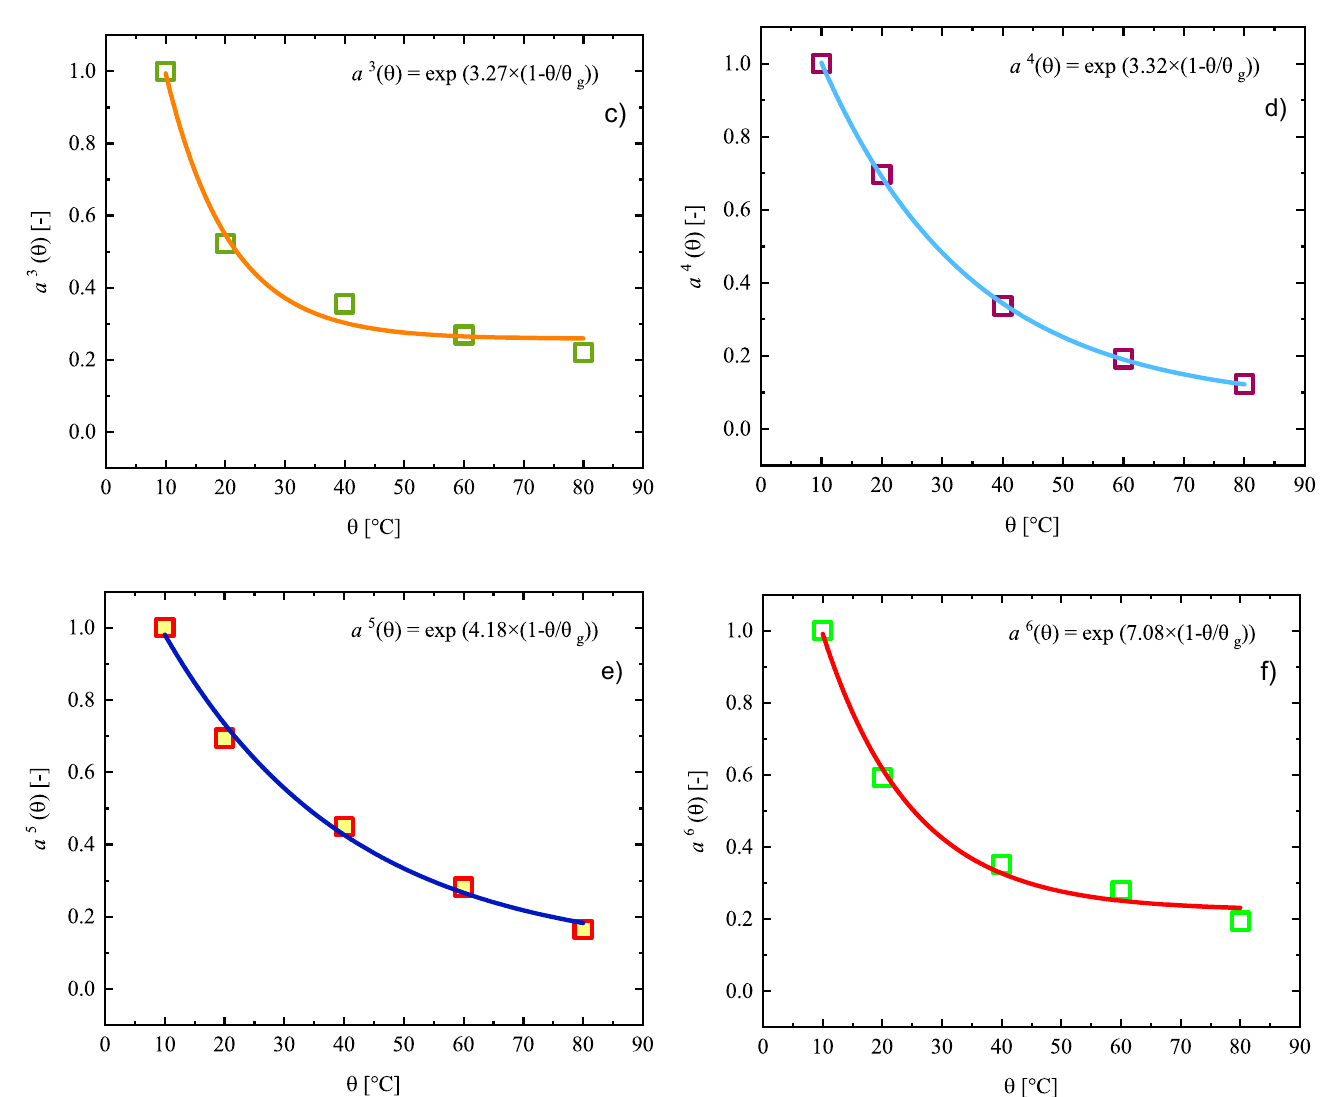
Figure 12. ( a – f ): Identification of the shift functions a j ( θ ) for the set of six Maxwell